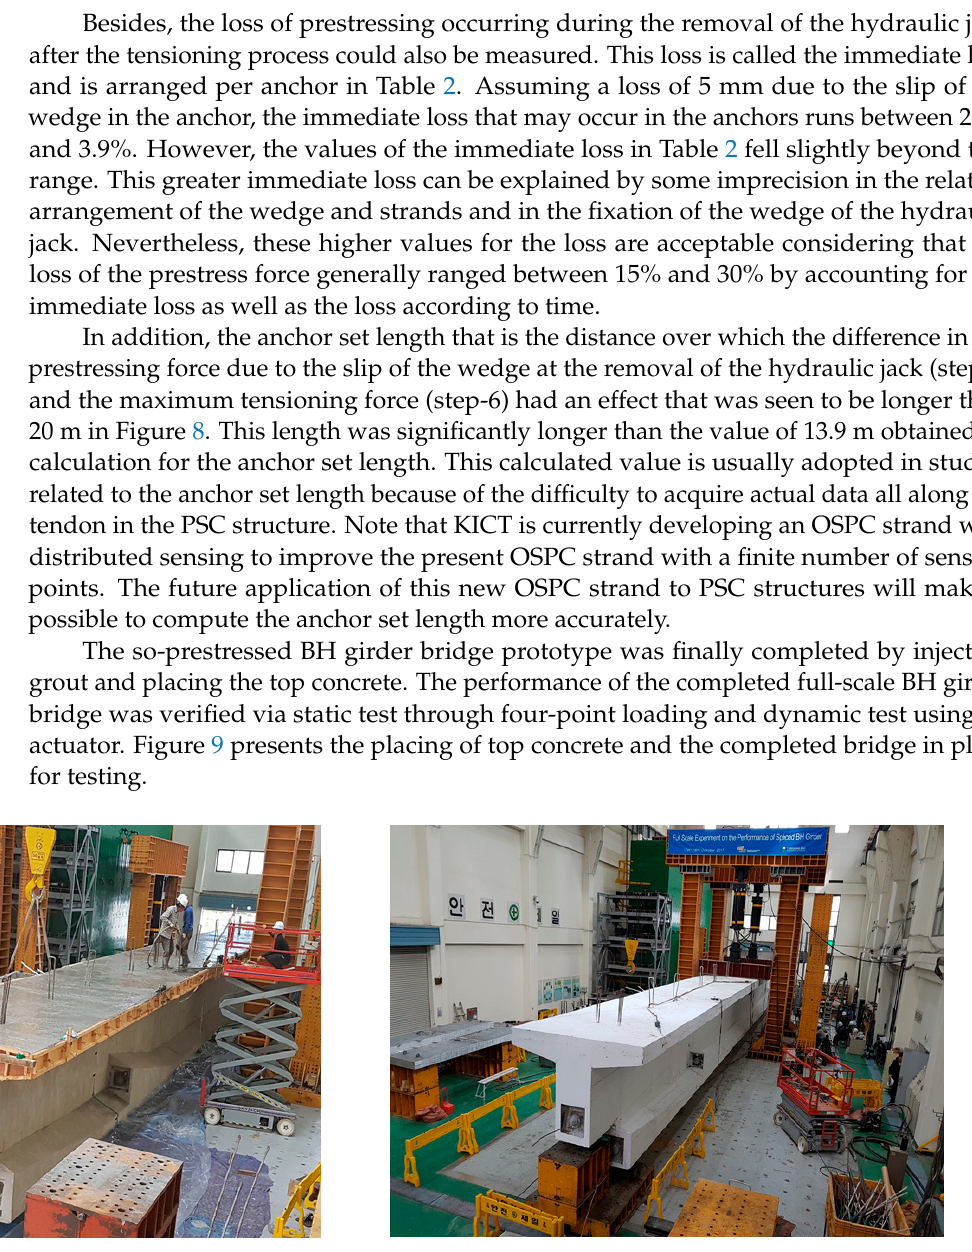
Figure 9. Full-scale BH girder bridge prototype: ( a ) Placing of top concrete; ( b ) At completion and installed for loading